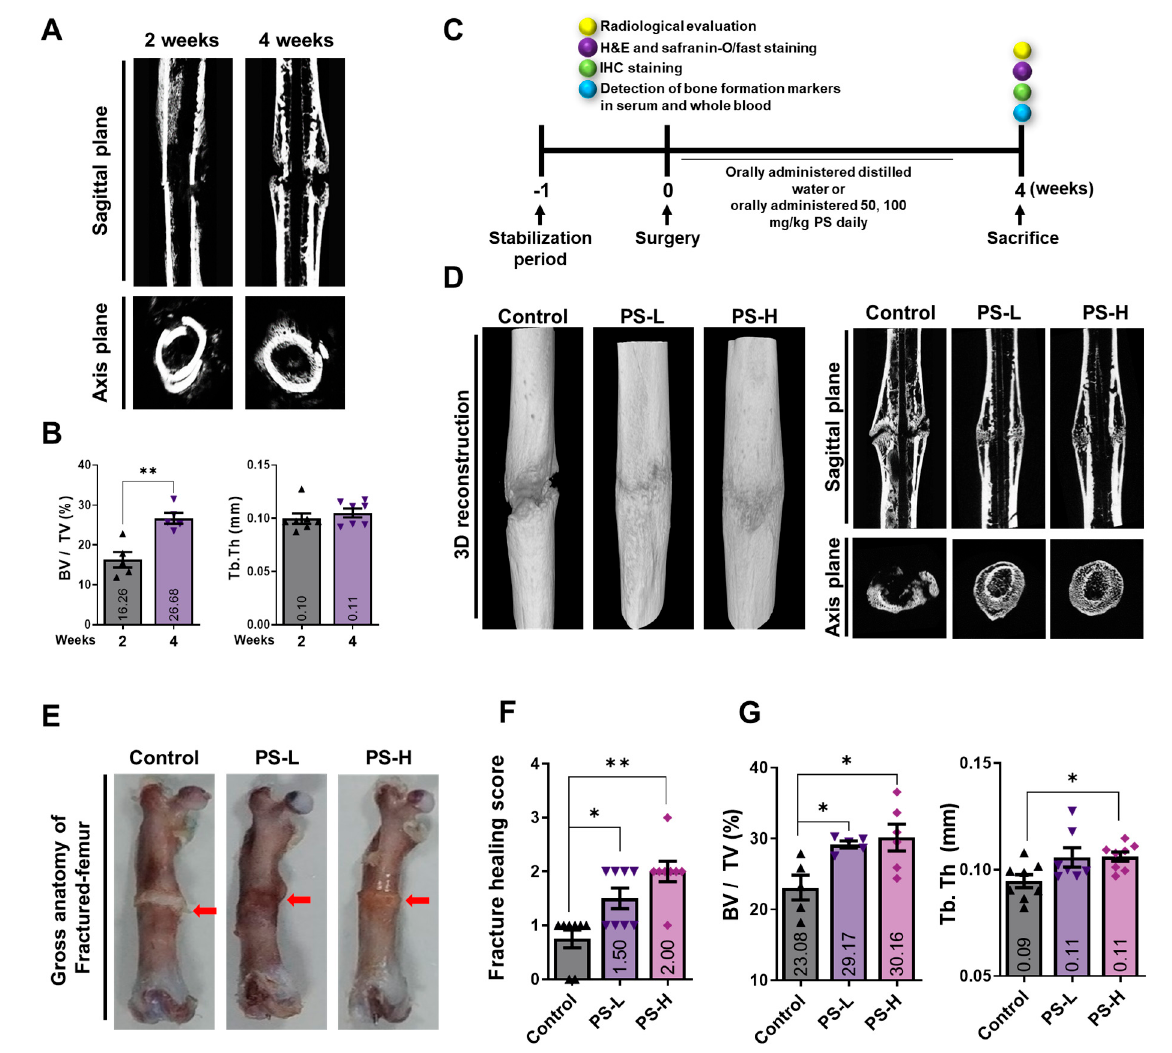
Figure 4. The bone-union-promoting effect of PS verified using a rat model of femoral fracture. ( A ) Preliminary study to set the experimental period. The femur was imaged using micro-CT following sacrifice at 2 and 4 weeks after fracture induction. ( B ) Changes in bone microstructure analyzed using the SkyScan software. ( C ) Design of experiments to evaluate the effects of PS on femoral fracture models. ( D ) Imaging of the fractured femur using 3D reconstruction, sagittal plane, and axis plane methods and micro-CT analysis equipment. ( E ) Gross anatomy of the fractured femur extracted and photographed using a camera for analysis, with the position of the fracture line indicated by the red arrow. ( F ) Healing of fractured femurs scored through micro-CT. ( G ) Measurement of bone microstructure of the imaged callus measured using SkyScan software. The shapes (triangles, squares, etc.) shown in each graph are values for each experimental rat. Data are expressed as mean ± SEM. ** p < 0.01, * p < 0.05 versus the control group. Control, fracture and treated with vehicle; PS-L, fracture and treated with 50 mg/kg of PS; PS-H, fracture and treated with 100 mg/kg of